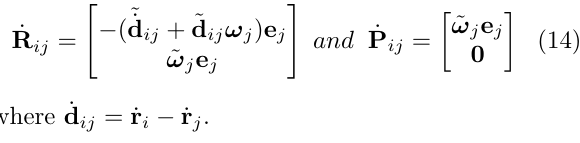
Figure 6: Variable location of extension system Centre of Mass